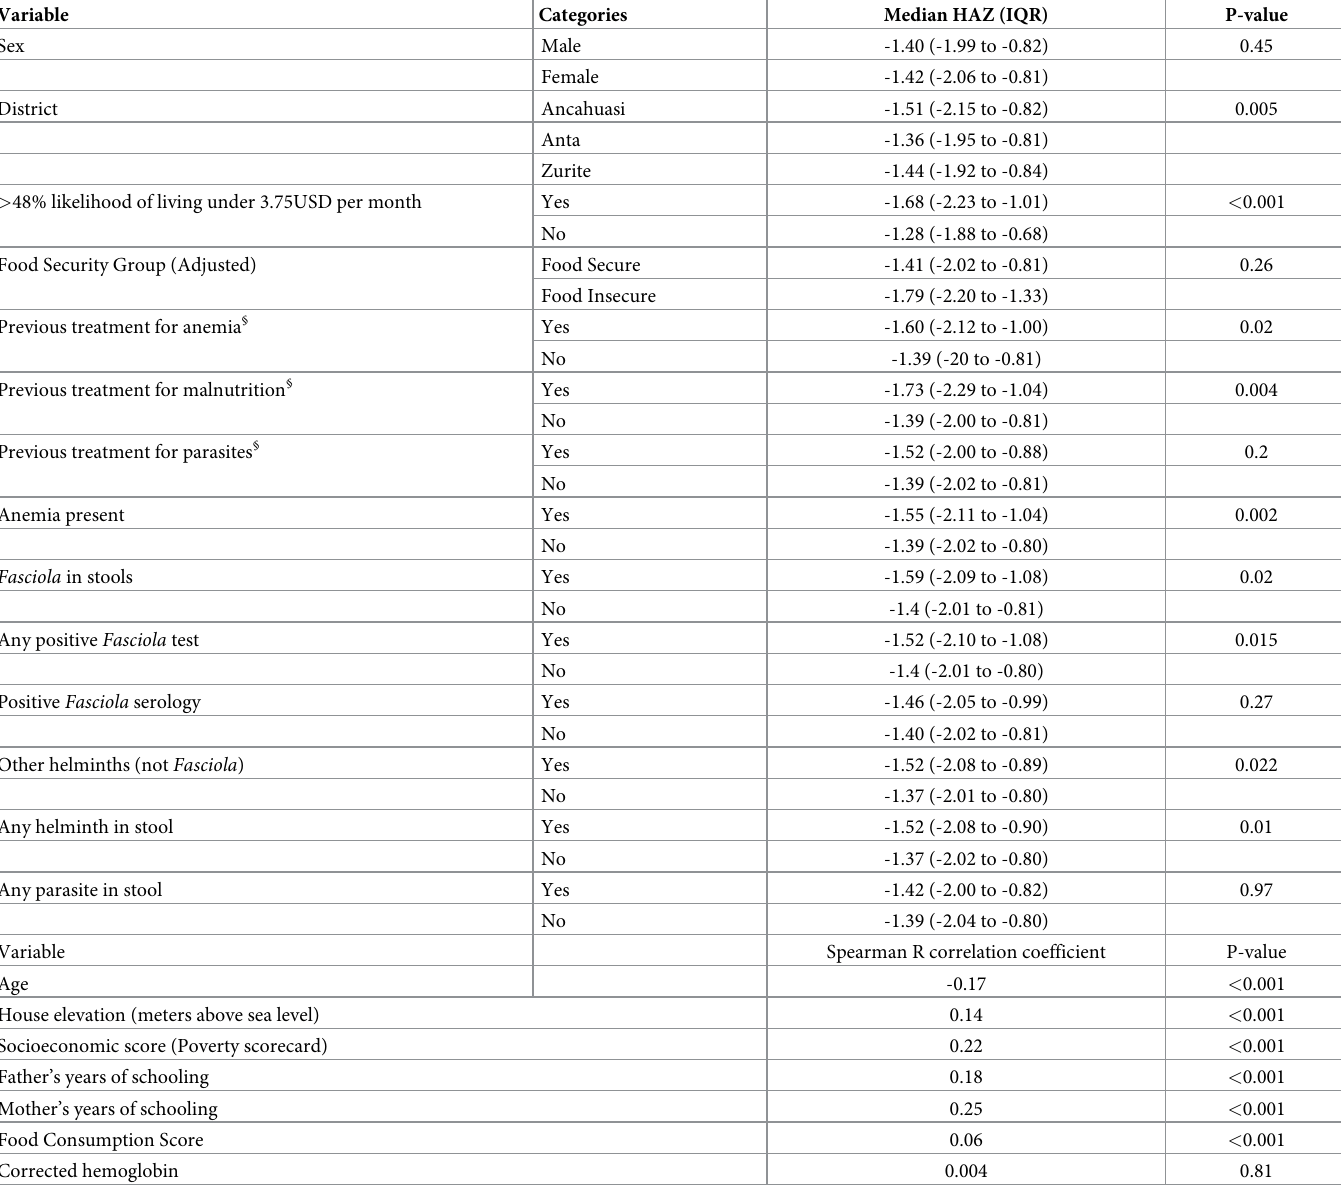
those not exposed to Fasciola (-1.54 vs. -1.4, p = 0.015), and those with chronic Fasciola also -1.4, p = 0.022). Positive serology for Fasciola alone was not associated with a lower HAZ score. The presence of other helminths in stool was associated with a lower median HAZ score (-1.47 vs. -1.39, p = 0.01) (Table 2). Participants with more than one intestinal helminth had a p = 0.003). Table 2. Bivariate analysis of the association between HAZ score and demographic, socioeconomic, and parasitological variables.